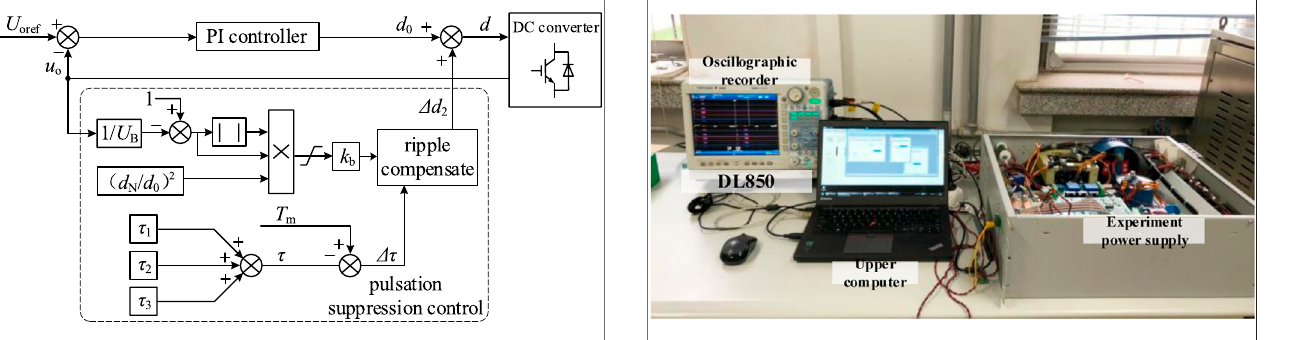
FIGURE 7 | Control block diagram of voltage ripple suppression.